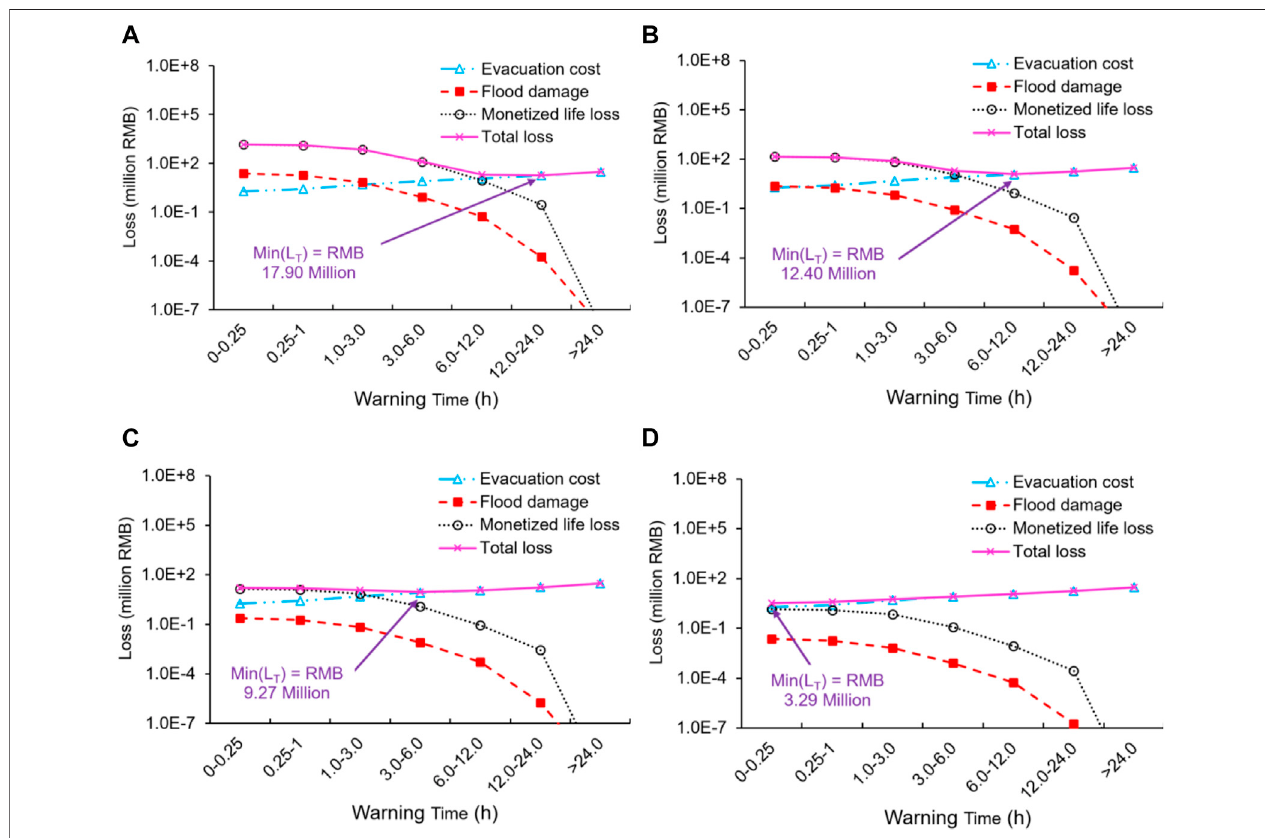
FIGURE 12 | The three types of losses and the total loss in Scenario 2 in Beichuan County with different W t : (A) P f (cid:2) 1; (B) P f (cid:2) 0.1; (C) P f (cid:2) 0.01; (D) P f (cid:2) 0.001.